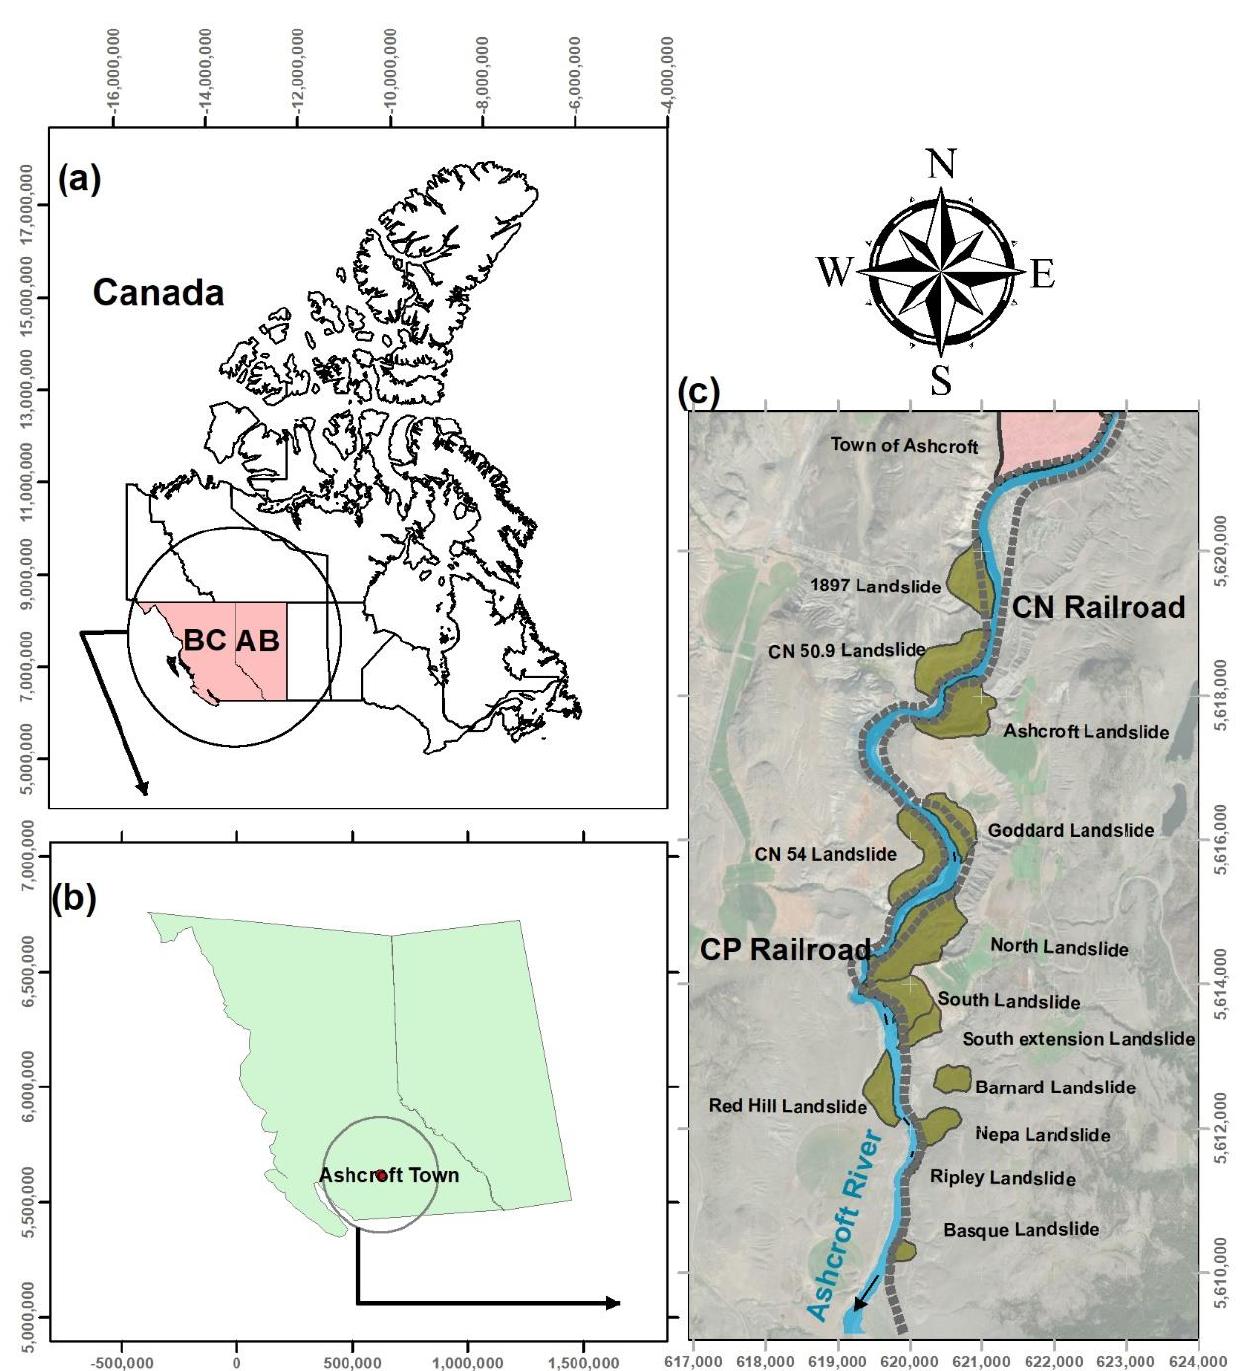
Figure 1. Thompson River valley location ( a , b ) plan-view and active landslides across the valley ( c ). Coordinates in UTM (units in meters for scale purposes). BC and AB in ( a ) correspond to the provinces of British Columbia and Alberta, respectively.